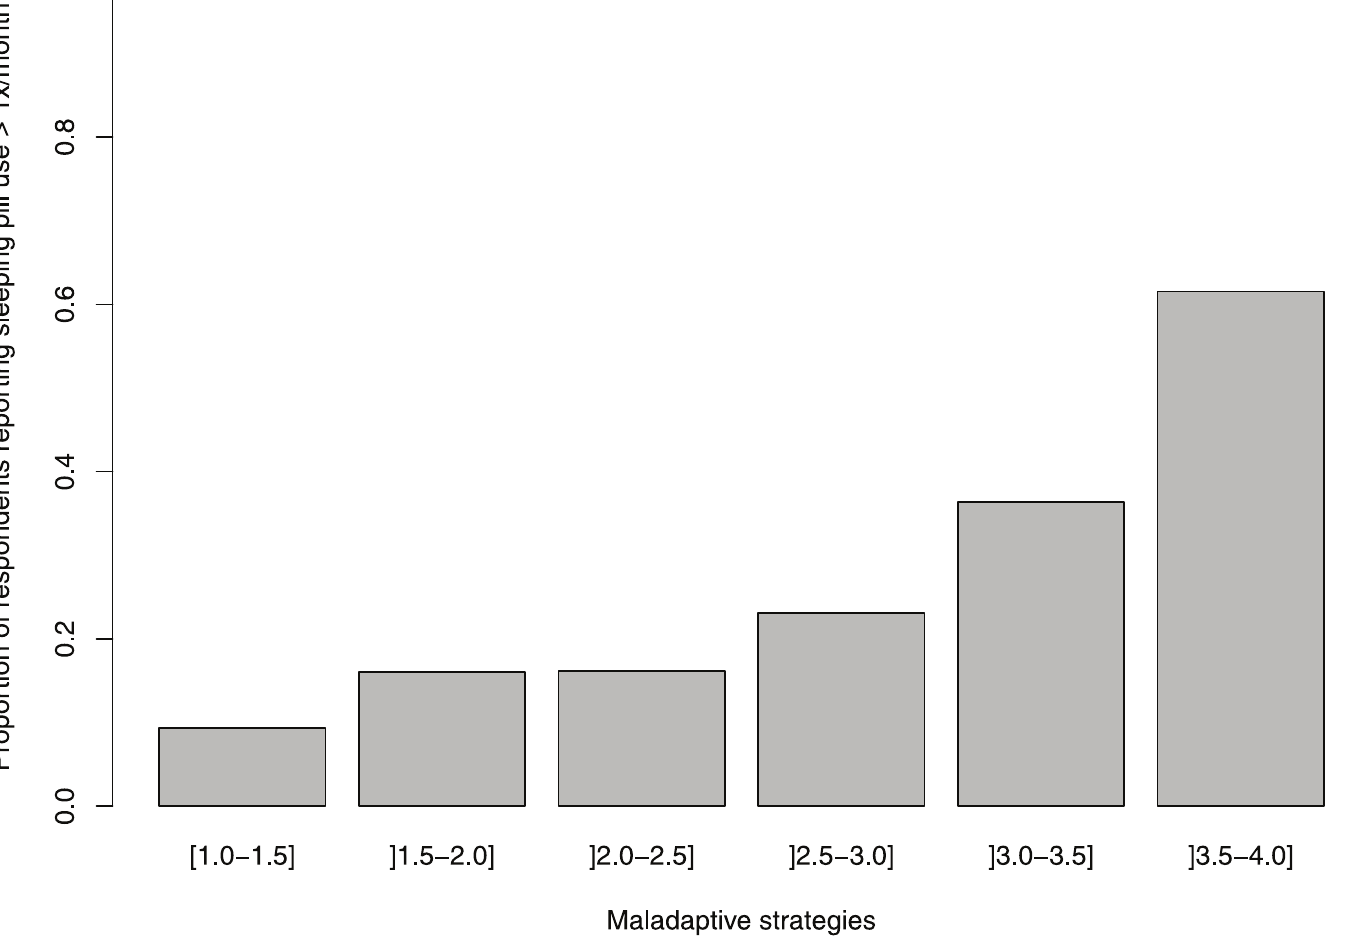
Fig 2. Proportion of respondents who reported using sleeping pills more than once a month by levels of maladaptive strategies.